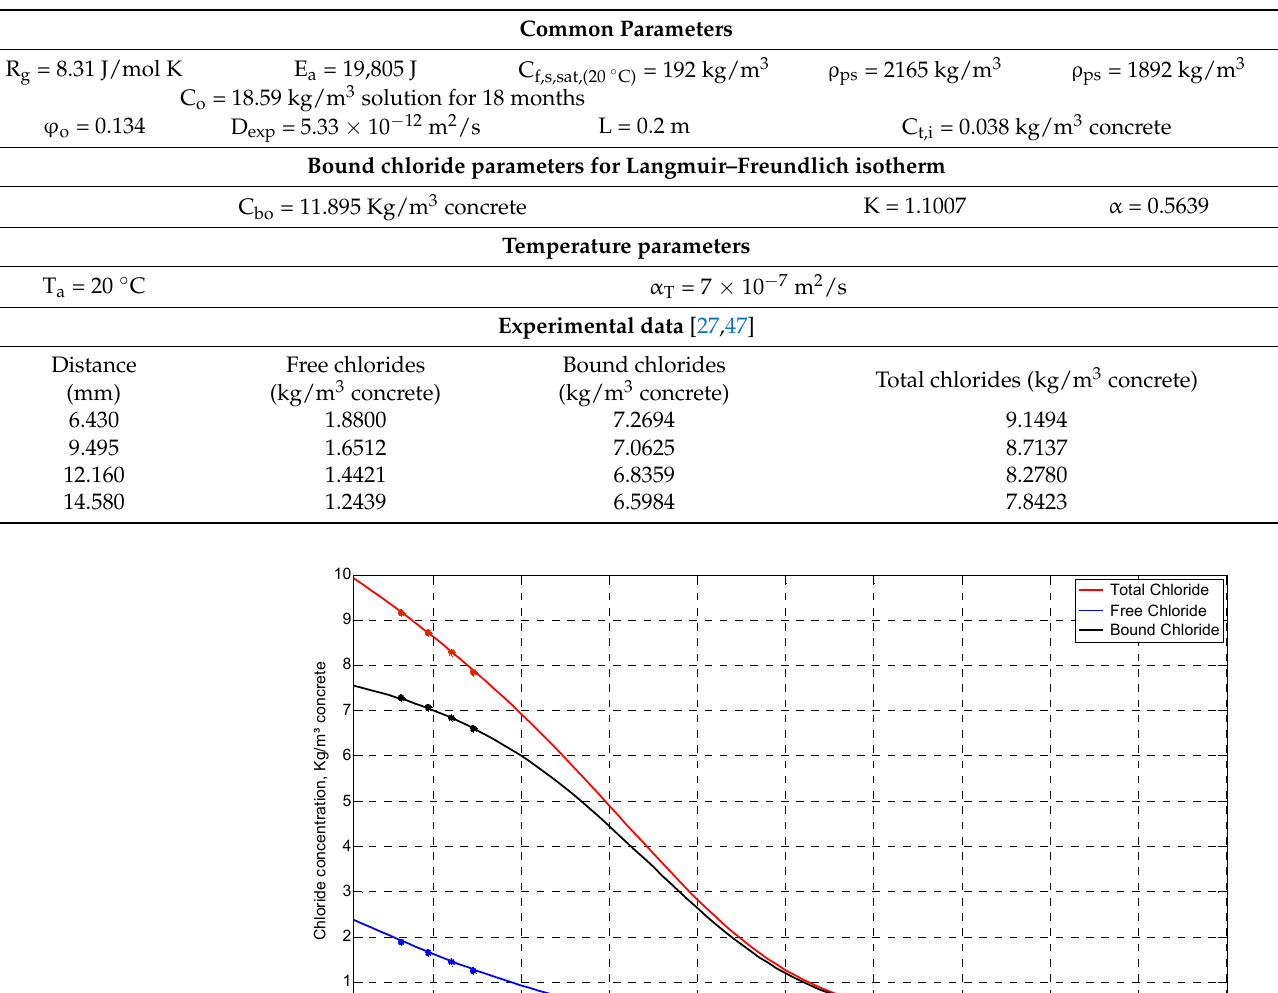
Table 3. Data of the first application (water-saturated concrete).